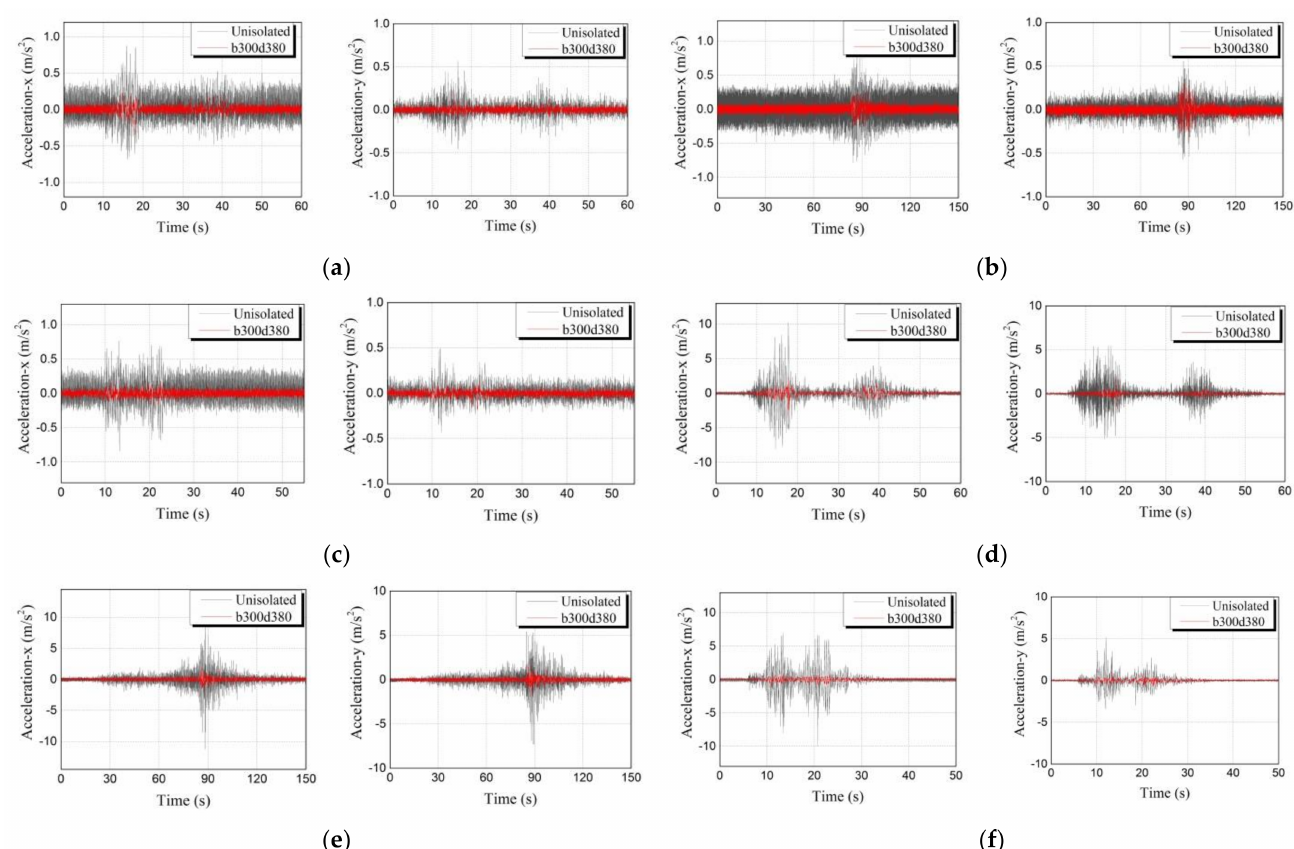
Figure 22. Acceleration comparisons between the equipment with b300d380 bearing and without isolation subjected to three high-frequency ground motions with PGA of 0.7 m/s 2 and 10 m/s 2. . ( a ) Acceleration comparisons under Wo-long ground motion (high-frequency) when PGA = 0.7 m/s 2 . ( b ) Acceleration comparisons under 311 ground motion (high-frequency) when PGA = 0.7 m/s 2. ( c ) Acceleration comparisons under IZIMIT ground motion (high-frequency) when PGA = 0.7 m/s 2